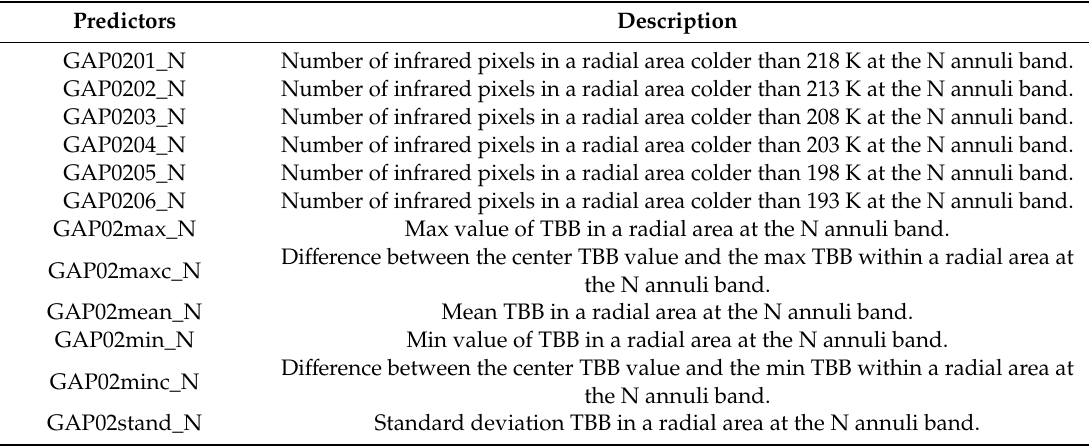
Figure 4. Annulus around the tropical cyclone (TC) center. The center of each figure corresponds to the TC eye. The innermost annulus is called the first annuli band, and the outermost annulus is called the 40th annuli band. Table 4. Satellite-based predictors.